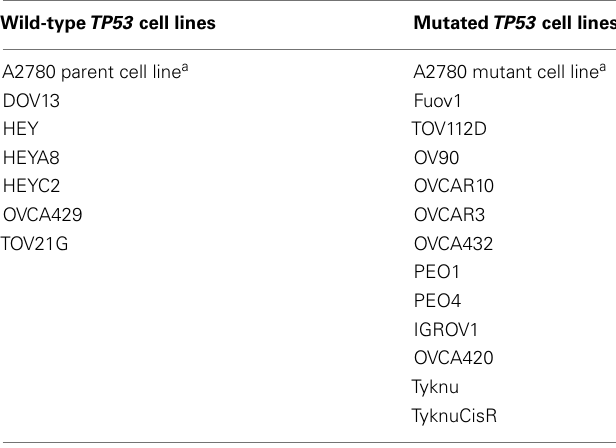
Table 1 | Immortalized ovarian cancer cell lines stratified by TP53 status